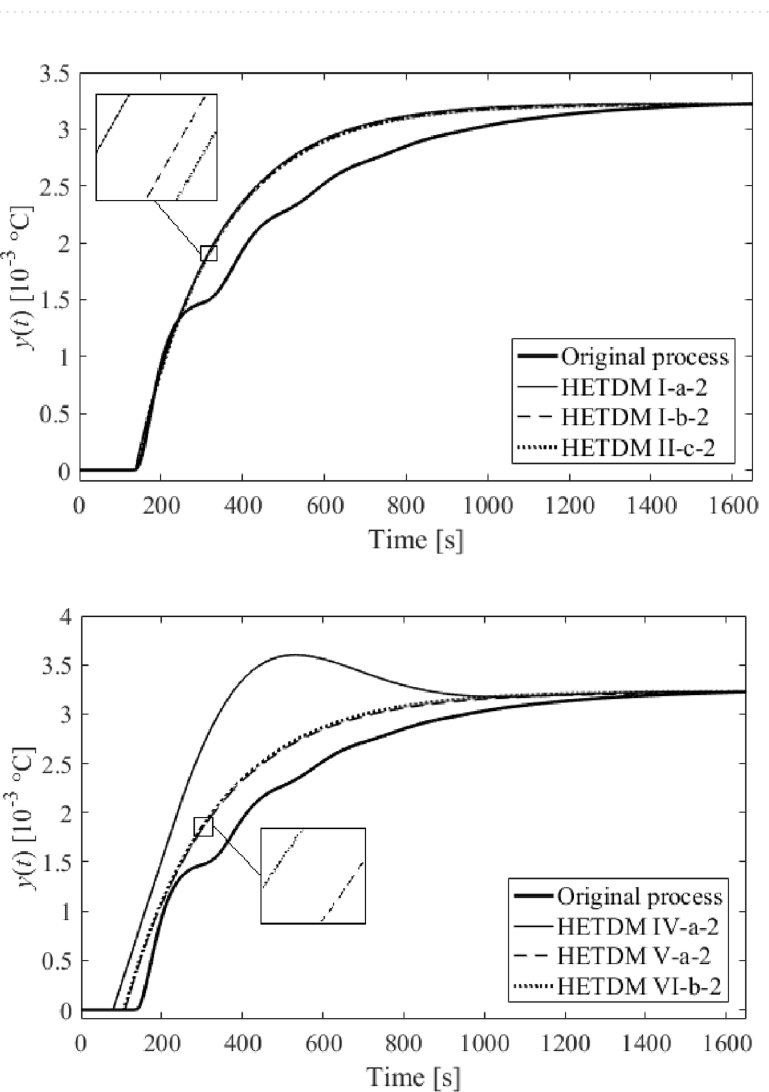
Figure 14. Comparison of selected HETDM unit step responses (vs. the original process response)—NM method used for transfer function numerator parameters